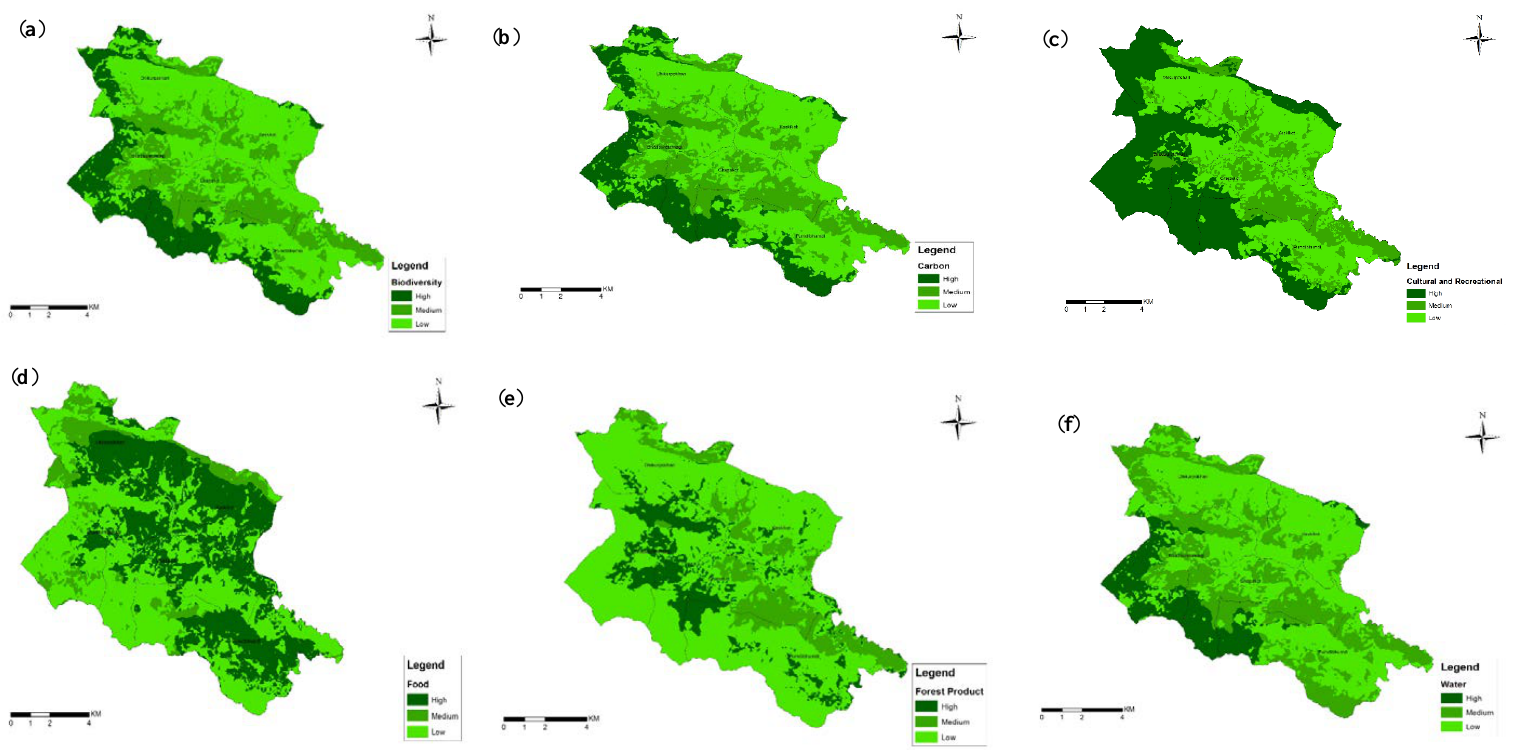
Figure 9. Mapping of distribution and availability of prioritized ecosystem goods and services in the study landscape: ( a ) Biodiversity, ( b ) carbon, ( c ) Cultural and recreational value, ( d ) Food Production; ( e ) Forest Products; and ( f ) Provision of water.